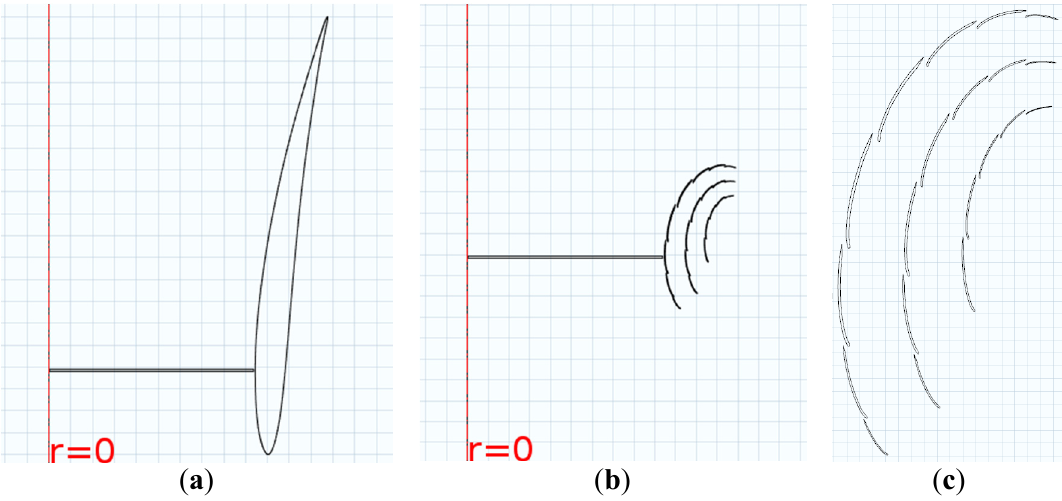
Figure 11. The two diffuser configurations: ( a ) Hansen diffuser; ( b ) Multi-element diffuser. (cid:1844)⁄ (cid:3404) 1.360 and (cid:1844) (cid:1844)⁄ (cid:3404) 1.374 for the Hansen The frontal areas are comparable: (cid:1844) (cid:2915)(cid:2934)(cid:2919)(cid:2930) (cid:2915)(cid:2934)(cid:2919)(cid:2930) and multi-element diffuser respectively. Lengthwise, the corresponding numbers are: (cid:1844)⁄ (cid:3404) 2.134 and (cid:1830) (cid:1844)⁄ (cid:3404) 0.736 , the latter being significantly more compact. (cid:1838) (cid:2914)(cid:2919)(cid:2916)(cid:2916) (cid:2914)(cid:2919)(cid:2916)(cid:2916) ( c ) Zoom of multi-element diffuser.